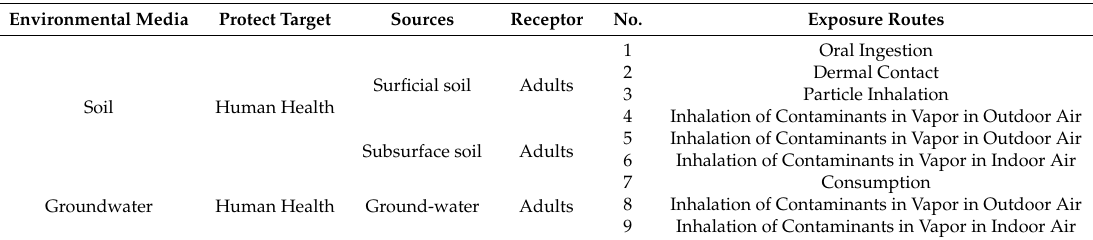
Table 3. Exposure-routes-receptor model for the Luhe